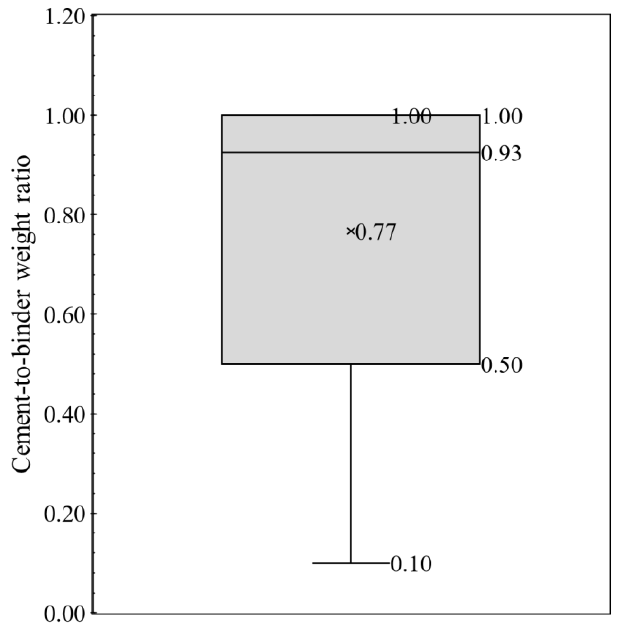
Figure 4. Whiskers box of cement-to-binder weight ratio for 157 mixtures design based on literature survey (data source: [30,44 – 85,89 – 92]).